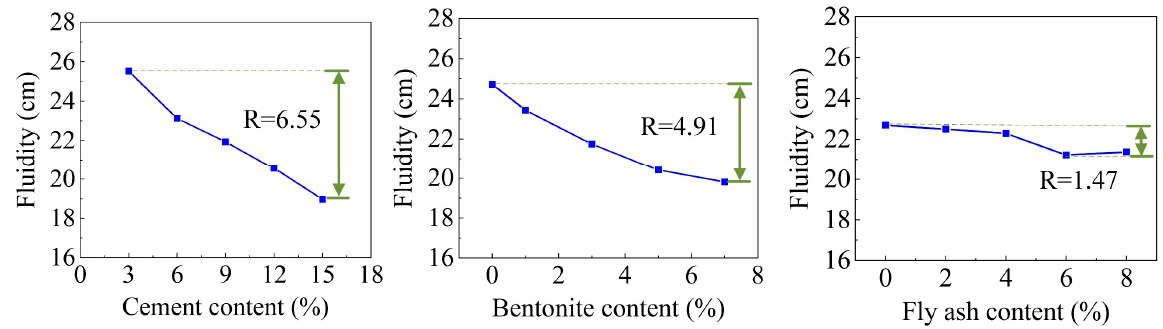
Figure 10. Range analysis of fl uidity.